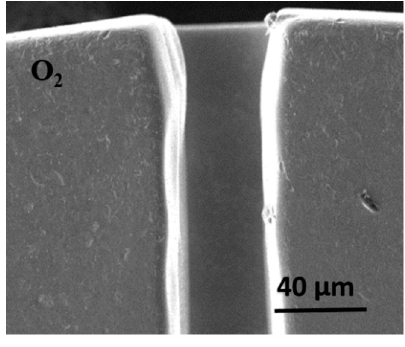
Figure 8. Topography of the oxygen sample processed with electrochemical polishing.